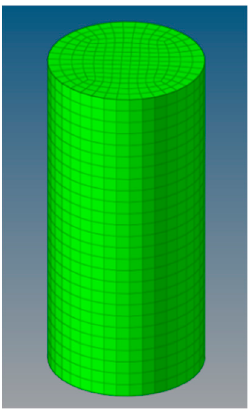
Figure 11. Column FE model used for topology optimization.